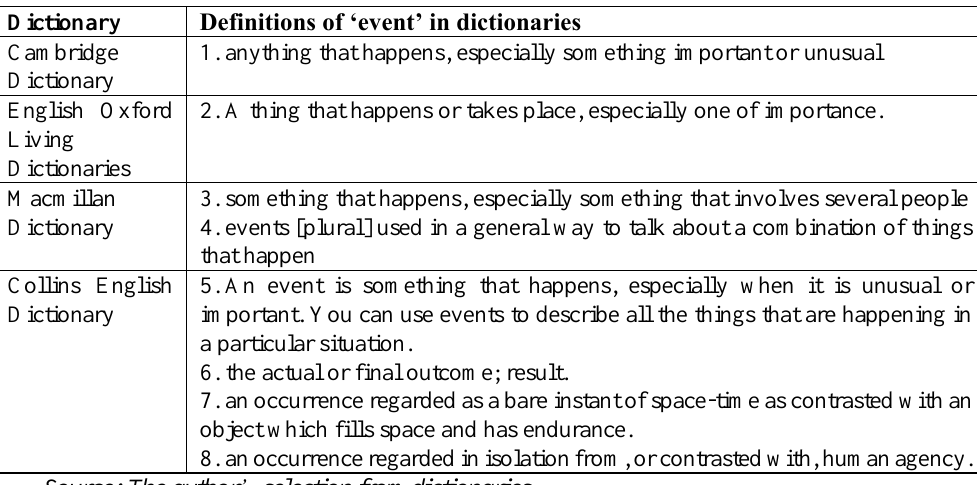
Table 6. Definitions of ‘event’ from several dictionaries